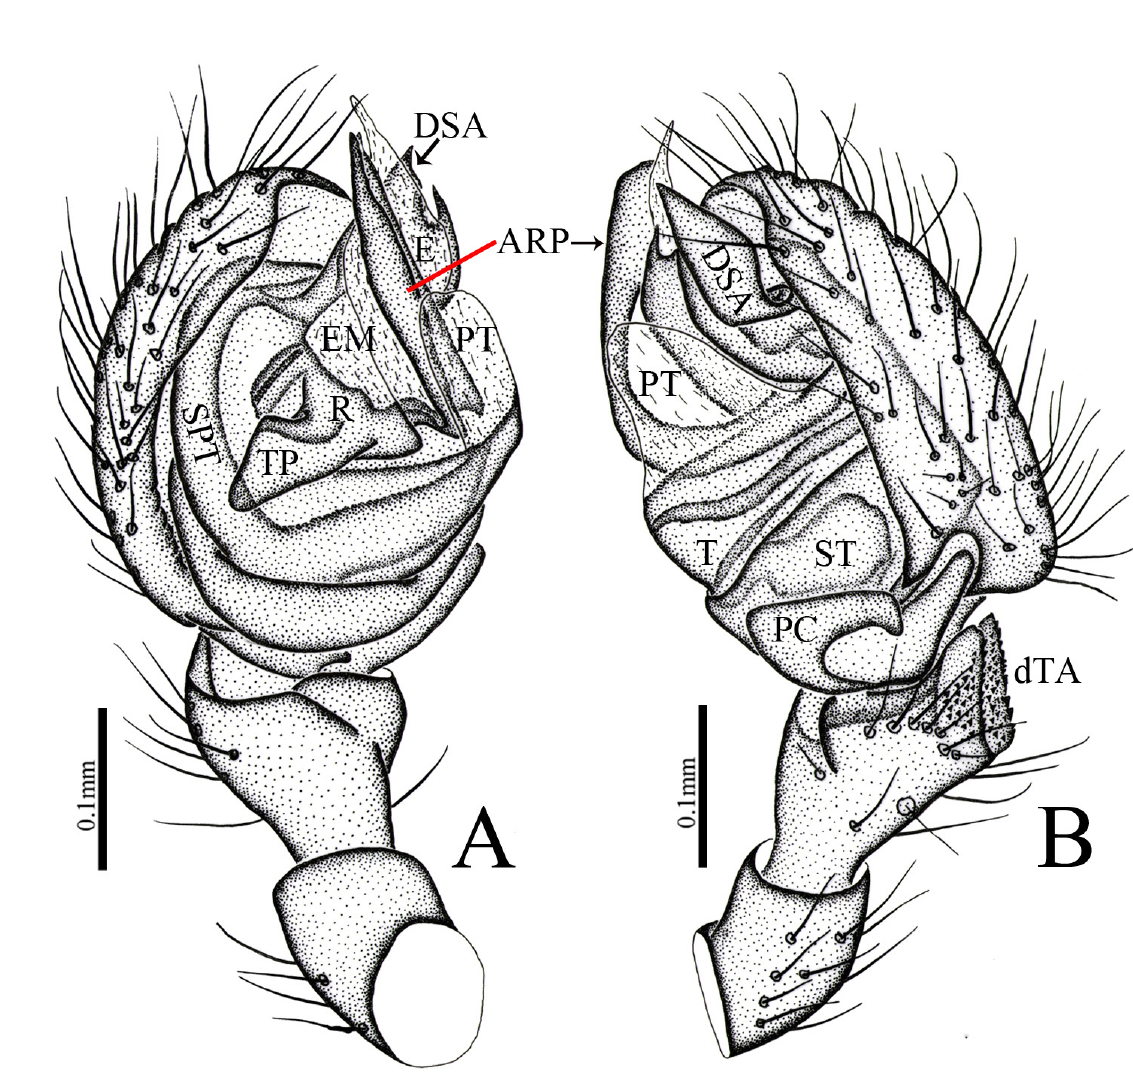
Fig. 2. Yuelushannus alatus sp. nov., male palp, holotype (HNDWS-18-04~01). A . Prolateral view. B . Retrolateral view. Scale bars: 0.1